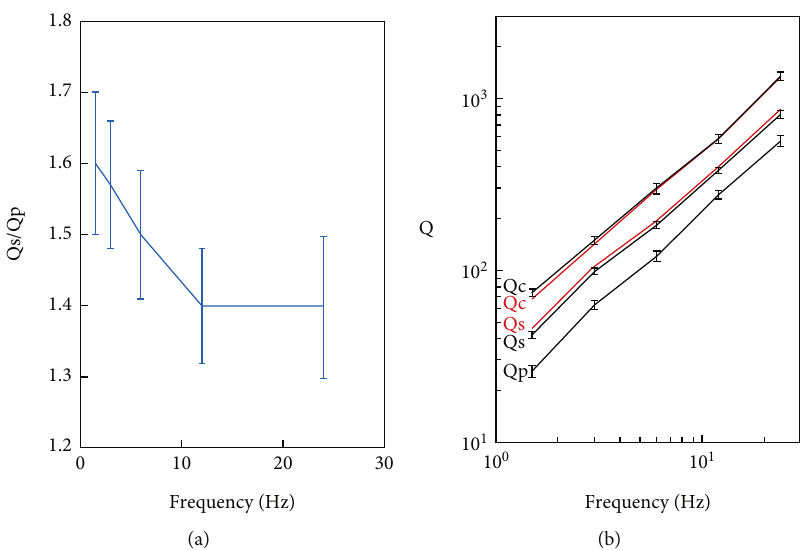
/ Q Figure 7: (a) Q ratio as a function of frequencies for study region. (b) Mean values of Q s p the Javakheti plateau (black lines) and the Racha (red lines)